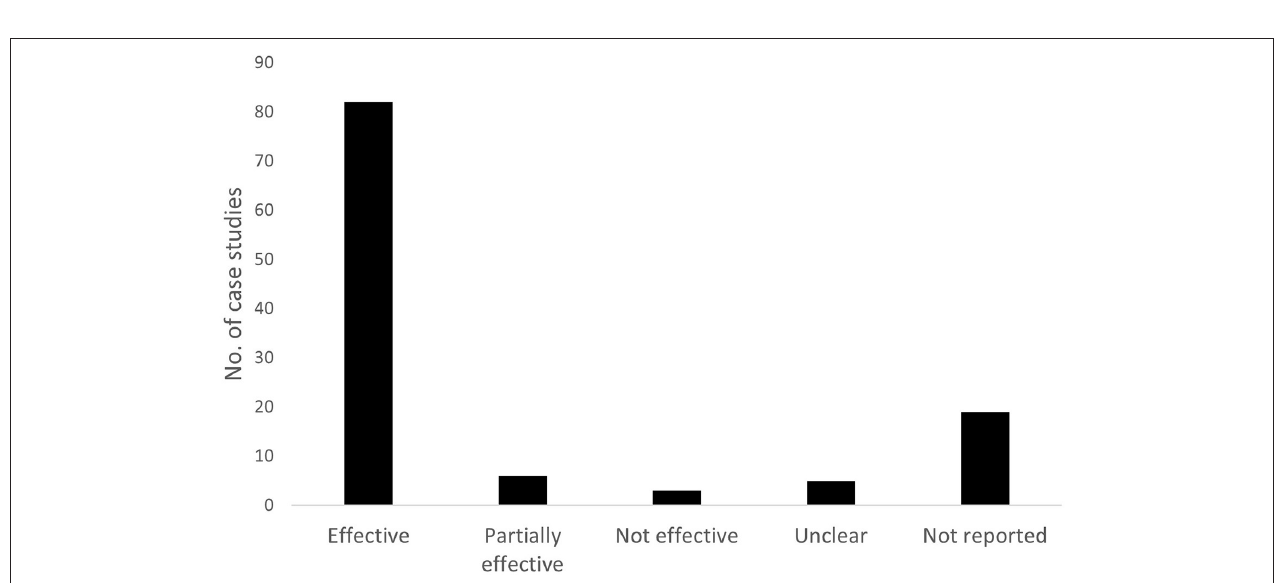
FIGURE 1 | Frequency with which case studies on the People not Poaching platform adopt an approach for engaging communities to decrease pressure on species from IWT including the proportion that are reported to be effective, partially effective or not effective, or where effectiveness was unclear or not reported. The approaches are aligned to pathways developed by Biggs et al. (2016) in a theory of change for community-based actions against wildlife poaching.